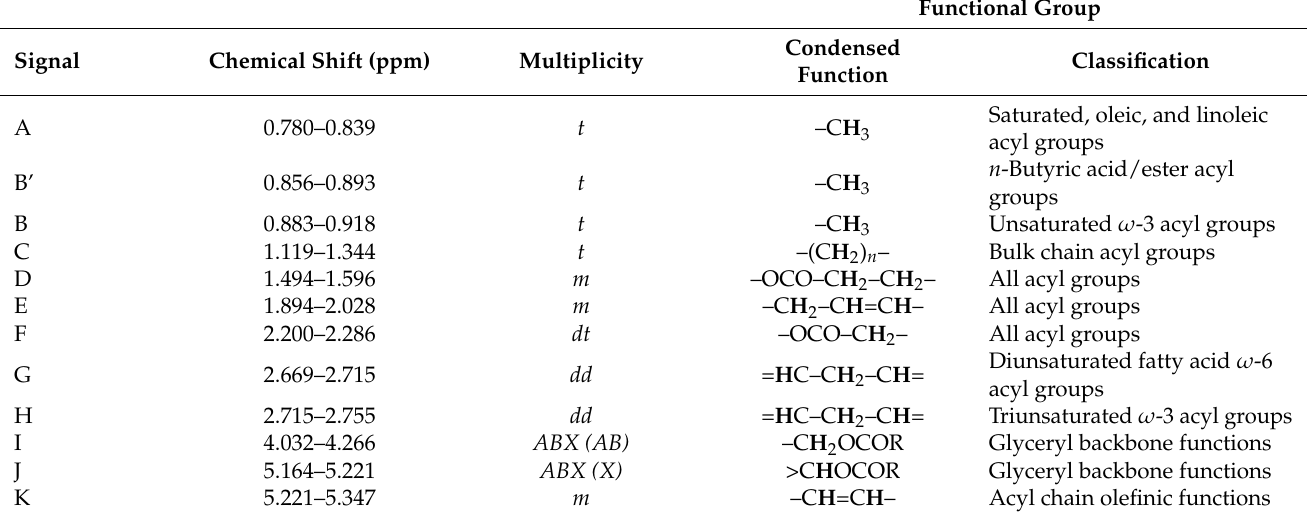
Table 2. Assignments of the major intense 1 H NMR signals of acylglycerol functions present in the 1 H NMR profiles of unheated culinary oils, including their chemical shift values and